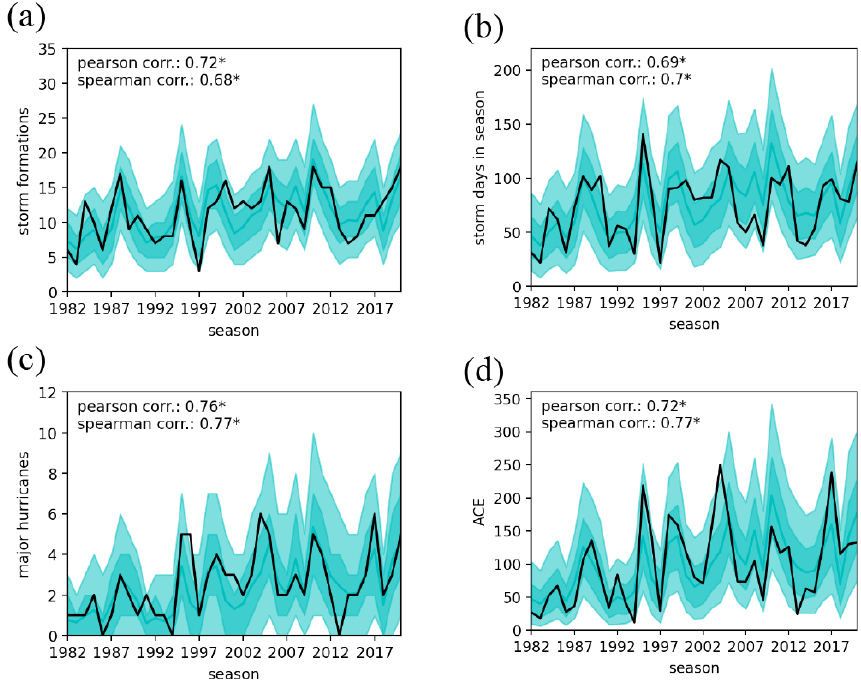
Figure 4. Cross-validated hurricane season emulations. (a) Number of storms as observed (black) and simulated (cyan). The light shading shows the 95% range of the 1000 simulations, and the darker shading shows the 66% range. The mean is indicated by a solid line. The cross-validated Pearson (Spearman) correlation coefficient between hindcasts and observations is indicated in the legend (see methods for more details on the decadal cross validation). (b) As panel (a) but for the number of storm days in a season. (c) As panel (a) but for the number of major hurricanes in a season. (d) As panel (a) but for the seasonal ACE.